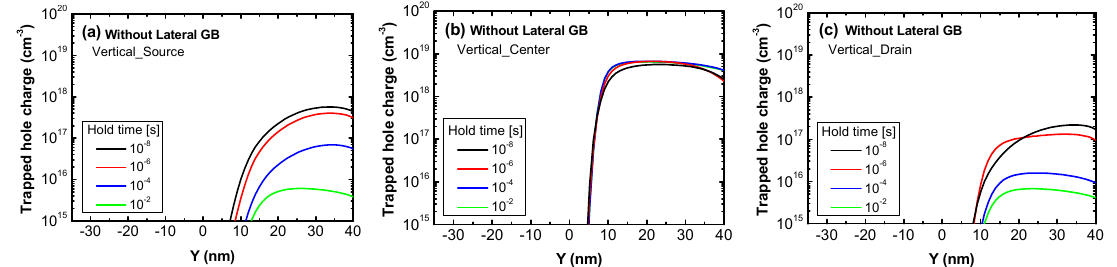
Figure 8. The trapped hole charge in the Read “1” operation of poly-Si 1T-DRAM devices that have no lateral GB as a function of a vertical GB’s position. The lines in each figure represent varied hold times to show their effect on the trapped hole charge. The devices are ( a ) Vertical_Source, ( b ) Vertical_Center and ( c ) Vertical_Drain.